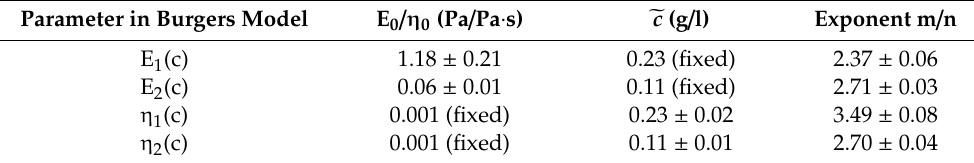
Table 4. Resulting fit parameters for the given functions, according to Equations (15) and (16).